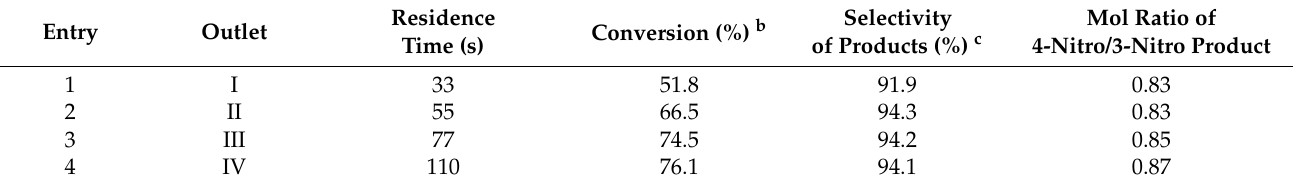
Table 1. Influence of residence time on the reaction a .